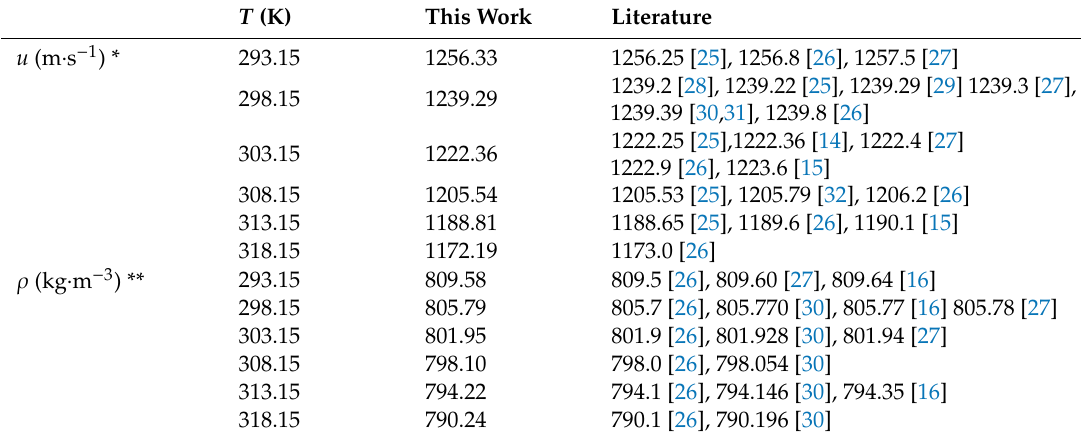
Table 1. Comparison of the speed of sound, u , and density, ρ , at atmospheric pressure obtained in this work with those reported in the literature.